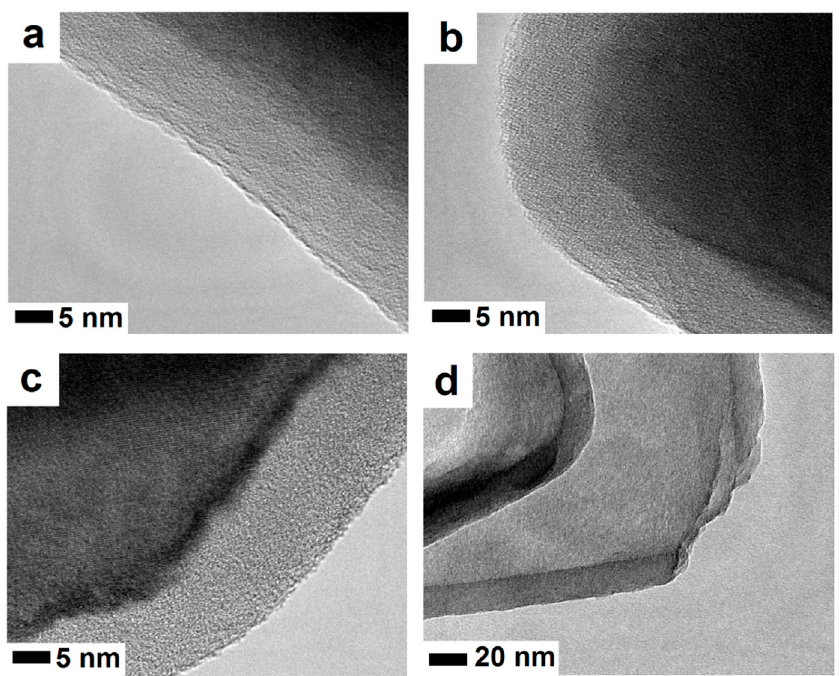
Figure 5. High-resolution transmission electron microscopy (HRTEM) images of the Fe 3 O 4 /SiO 2 particle ( a , b ) after exposure to 550 °C and ( c , d ) after exposure to 550 °C and acid aggression (Reprinted with permission from [39]. Copyright 2017 Elsevier).